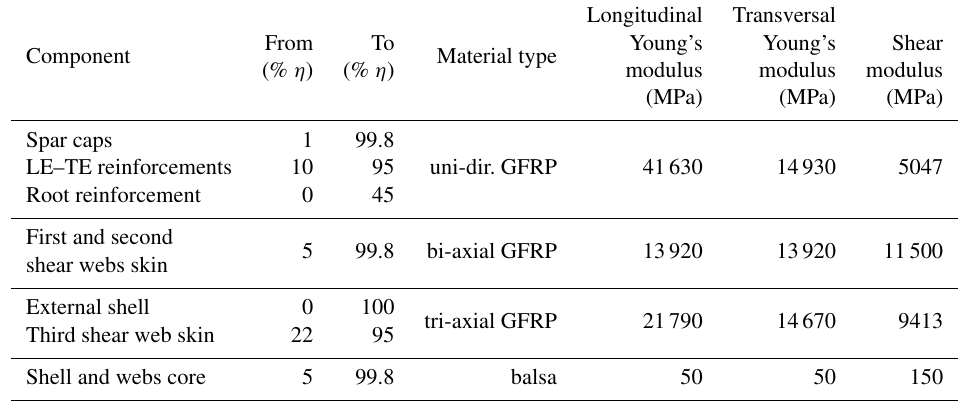
Table 2. Extent of the structural components and their materials in the blade of the 10MW wind turbine. Longitudinal Transversal From Component Material type